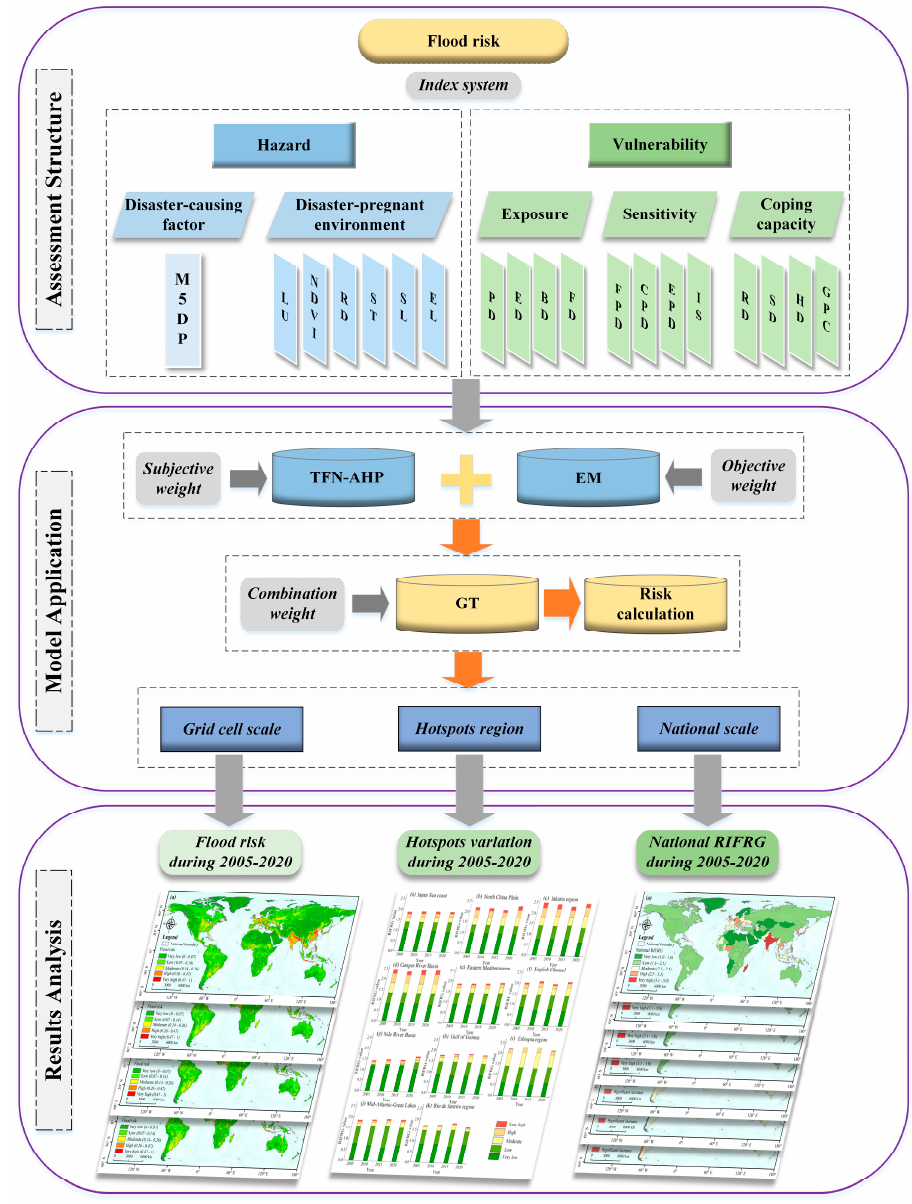
Figure 2. Flowchart for global flood risk assessment and spatiotemporal analysis.